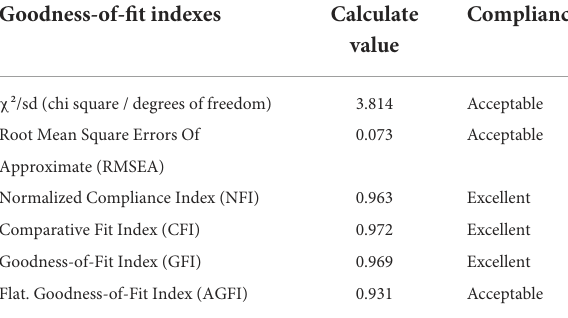
TABLE 7 Goodness-of-fit indexes of the model regarding the mediator role of students’ Conflict Resolution Needs Scale Scores between social anxiety and Psychological Abuse Scale Scores for adolescents and Rosenberg Self-Esteem Scale